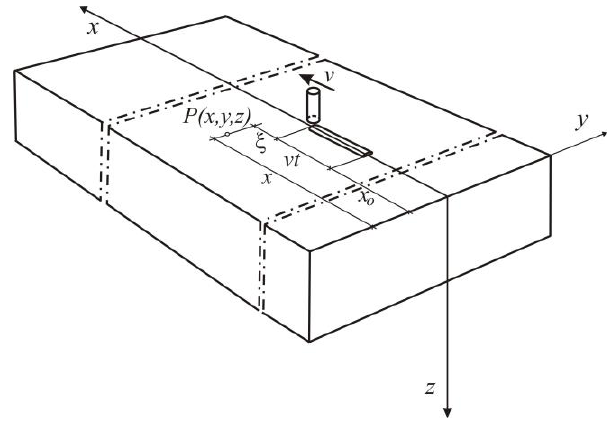
Figure 3. Arc weld surfacing